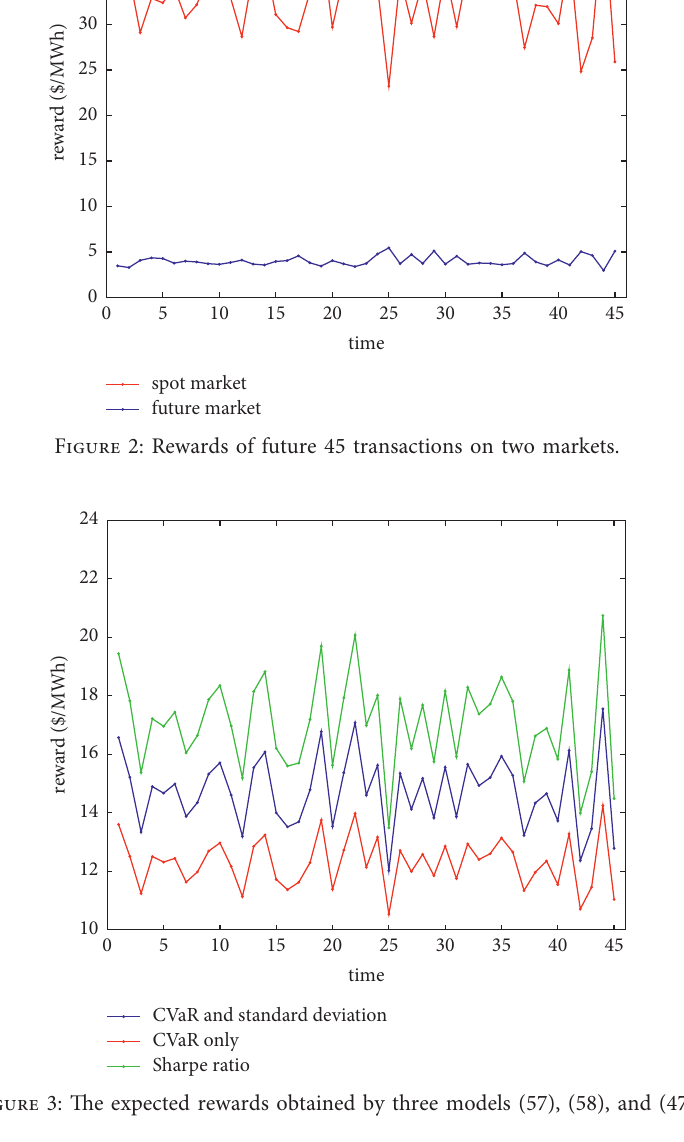
Figure 3: The expected rewards obtained by three models (57), (58), and